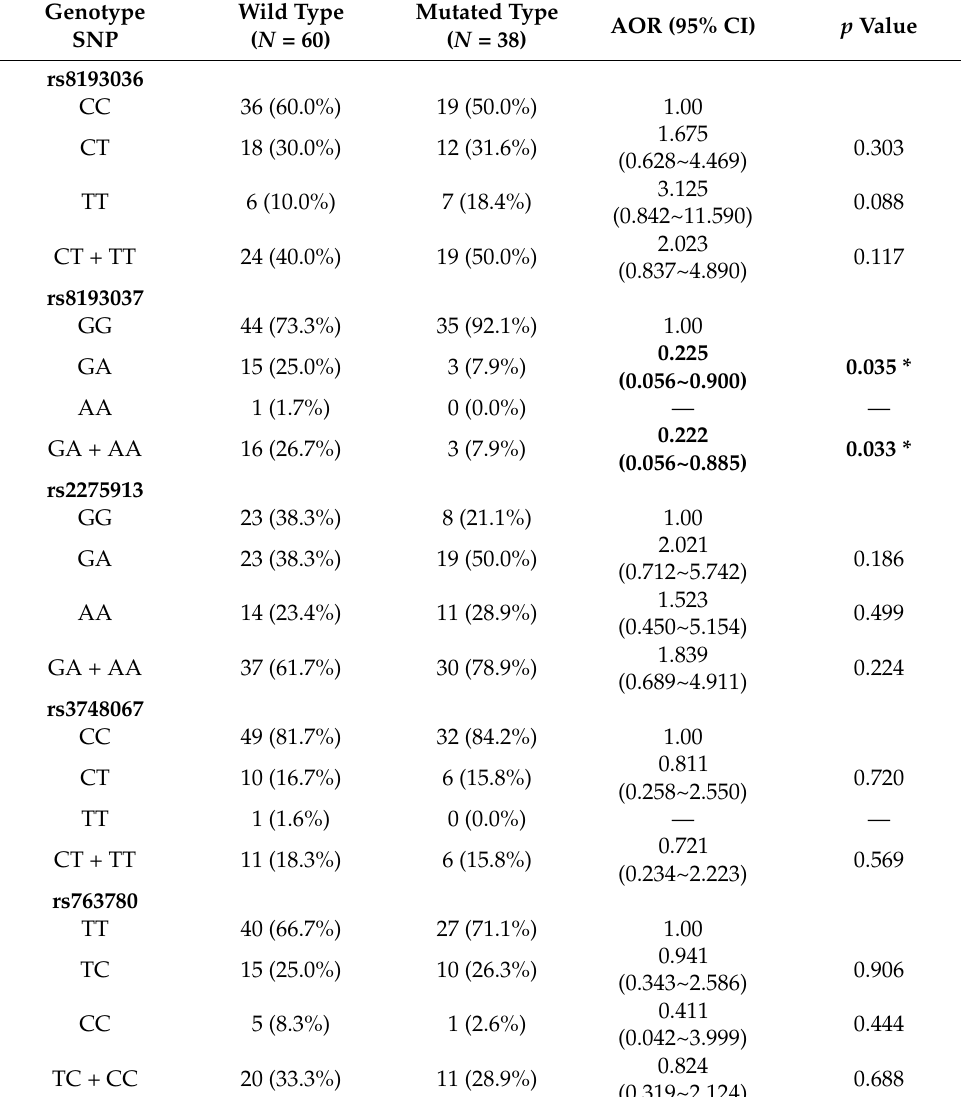
Table 2. Distribution frequencies of interleukin ( IL )- 17A genotypes of lung adenocarcinoma patients with the ever-smoking status and multiple logistic regression analysis of EGFR mutation